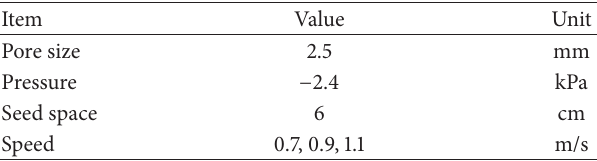
Table 4: Experiment parameters